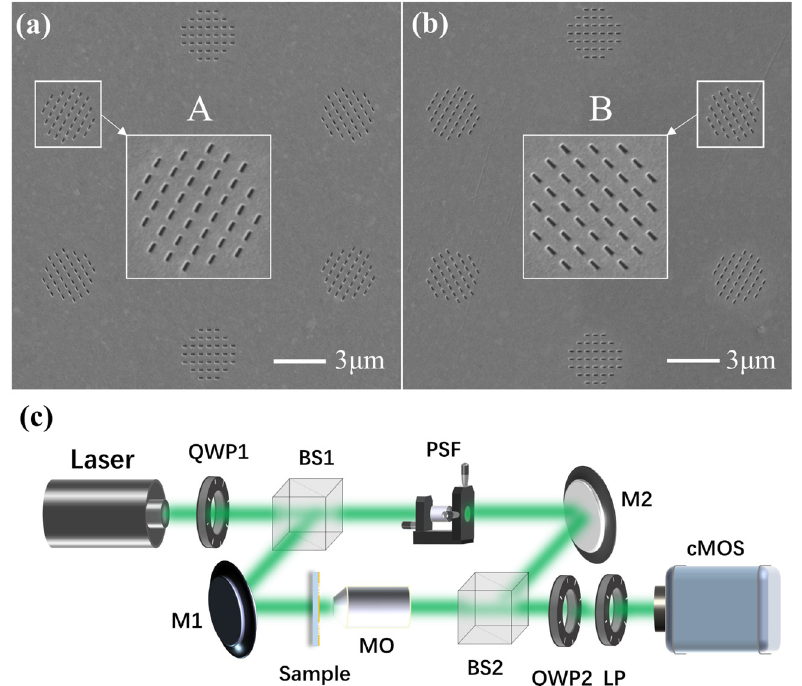
Figure 4: SEM images for samples and experimentalsetup:(a)and(b)showtheSEM images of samples A and B, respectively. (c) Schematic diagram of the experimental